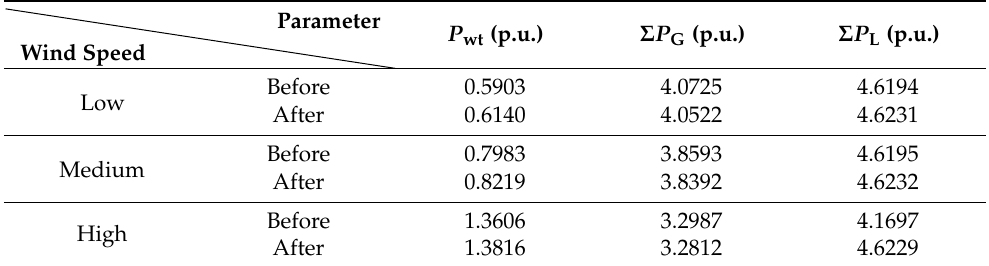
Table 3. Steady state power flows under different wind speeds before and after optimization of H DC .